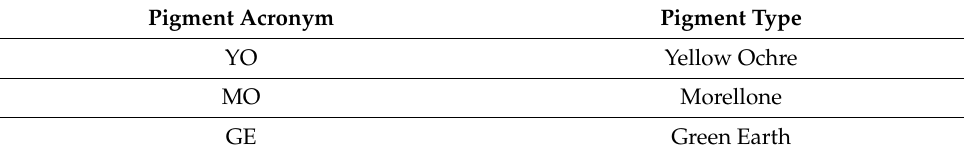
Figure 1. ( a ) Affresco mock-up (45 × 12 cm 2 ) subdivided in 3 areas (15 × 12 cm 2 ). From left to right: yellow ochre (YO), morellone (MO), green earth (GE) pigments; t 0 —reference area, t 1 —treatment with shellac; ( b ) set-up scheme for temperature monitoring: IR camera is positioned at 45° and laser at 90° with respect to the sample surface. Table 1. Pigments and their acronyms used in the fresco